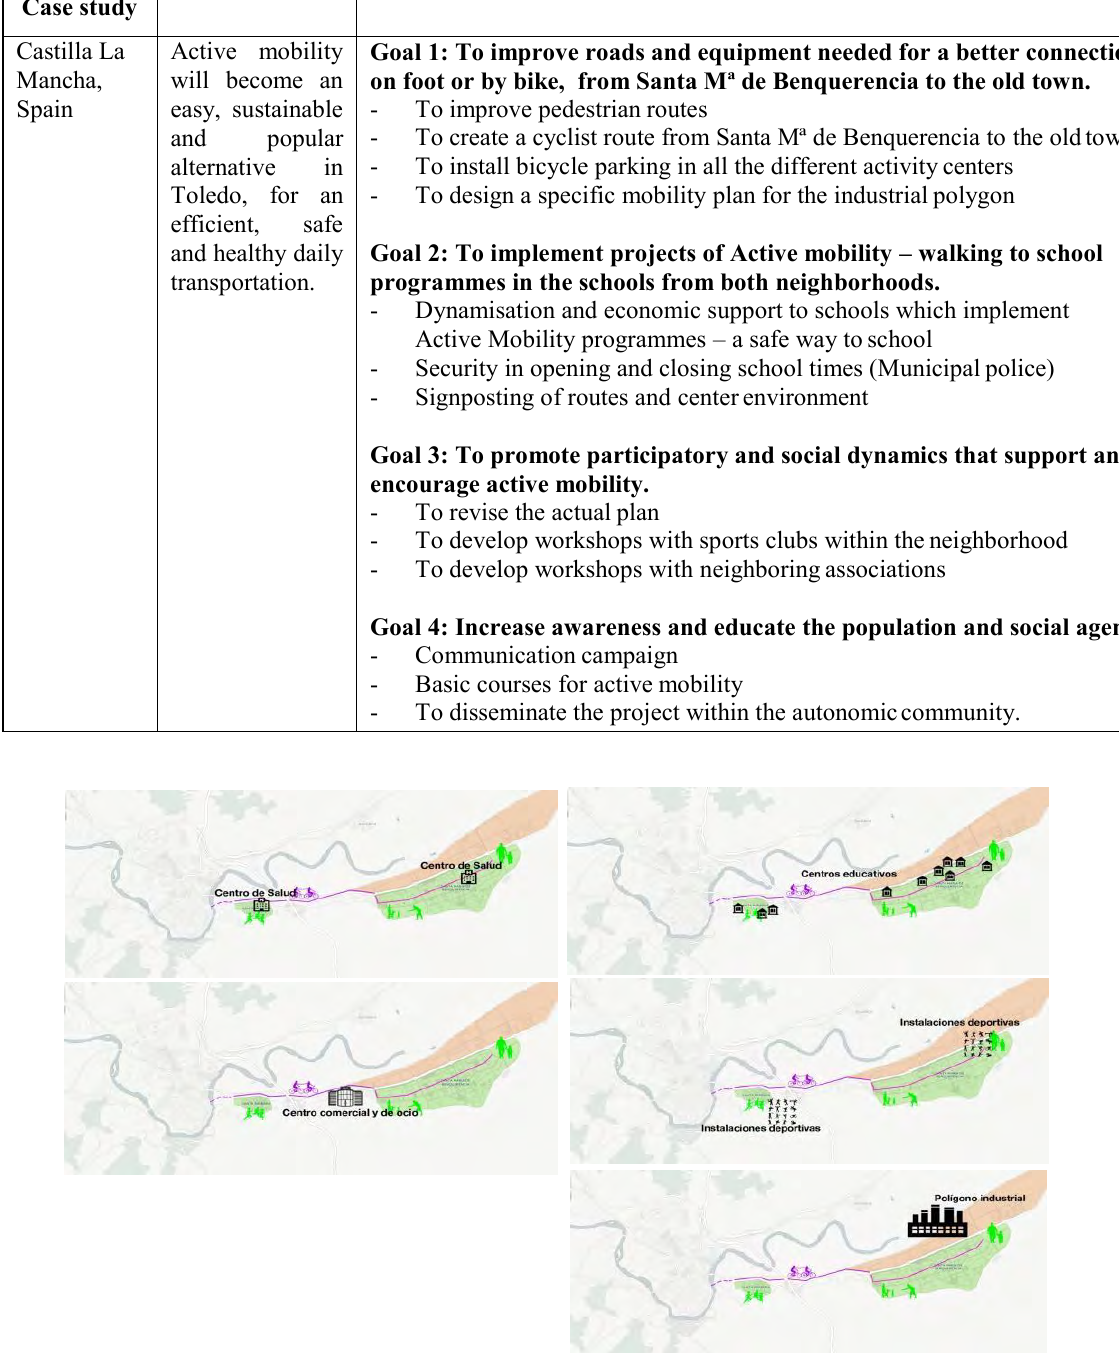
Figure 4 – Cyclist routes from Toledo to Santa María de Benquerencia